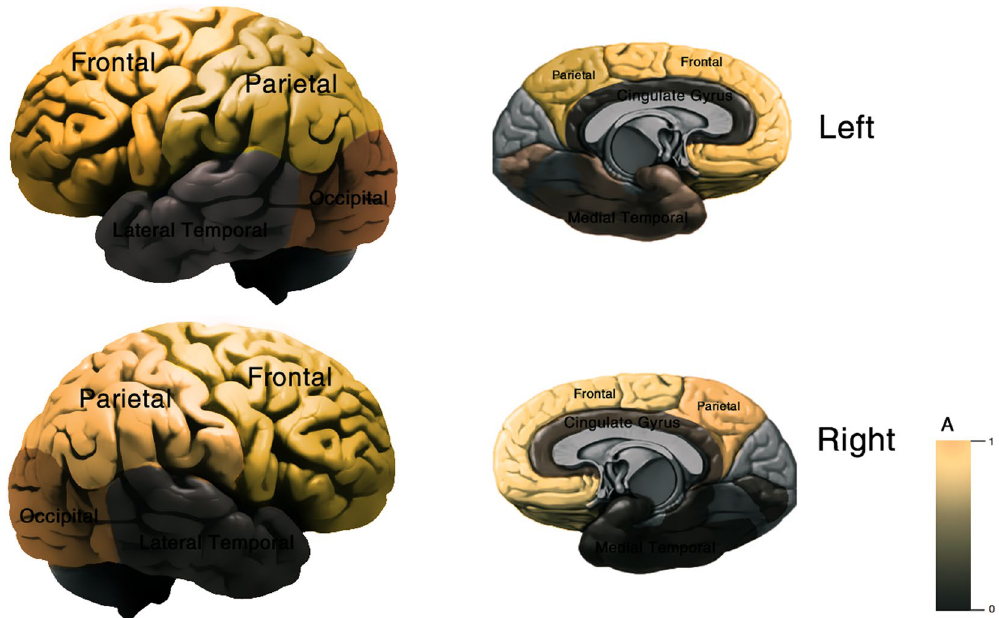
Figure 2. Additive genetic effects in both hemispheres. We mainly divided the brain into 6 lobes which is frontal/parietal/occipital/medial temporal/cingulate gyrus/lateral temporal by different colors. “A” (the color key) means heritability represented certain brain regions,